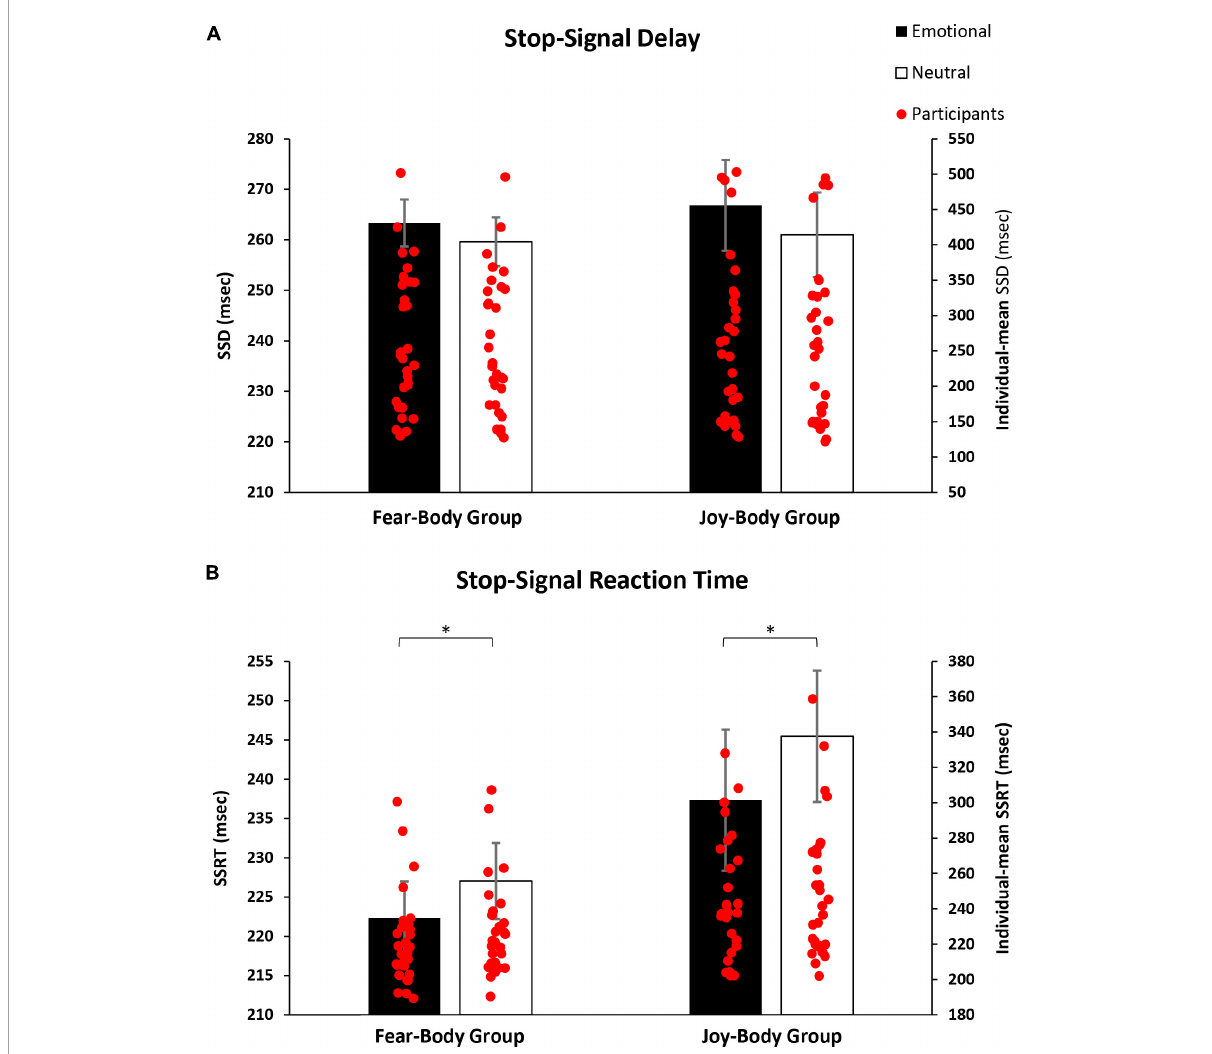
FIGURE3 Bar graphs of the experimental results. In panel (A) , the graph shows the mean stop-signal delay (SSD), demonstrating that the emotional content of stimuli influenced the participant’s action execution leading to a specific differentiation of SSD, given the successful staircase procedure. In panel (B) , the graph shows the mean stop-signal reaction time (SSRT), demonstrating that participants showed a better inhibitory process when facing emotive Stop-signals as compared to neutral ones, regardless of the group. ∗ Indicate significant comparisons ( p < 0.05), and error bars represent